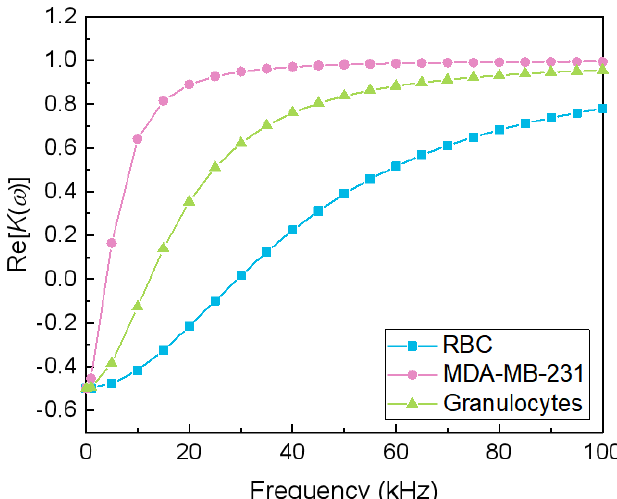
Figure A12. The dependence of Re[𝐾(𝜔)] of cells (RBC, WBC, CTC) on frequency at medium conductivity of 𝜎 (cid:3040) = 0.002 S/m. All calculations are based on Equation (5) in the manuscript.